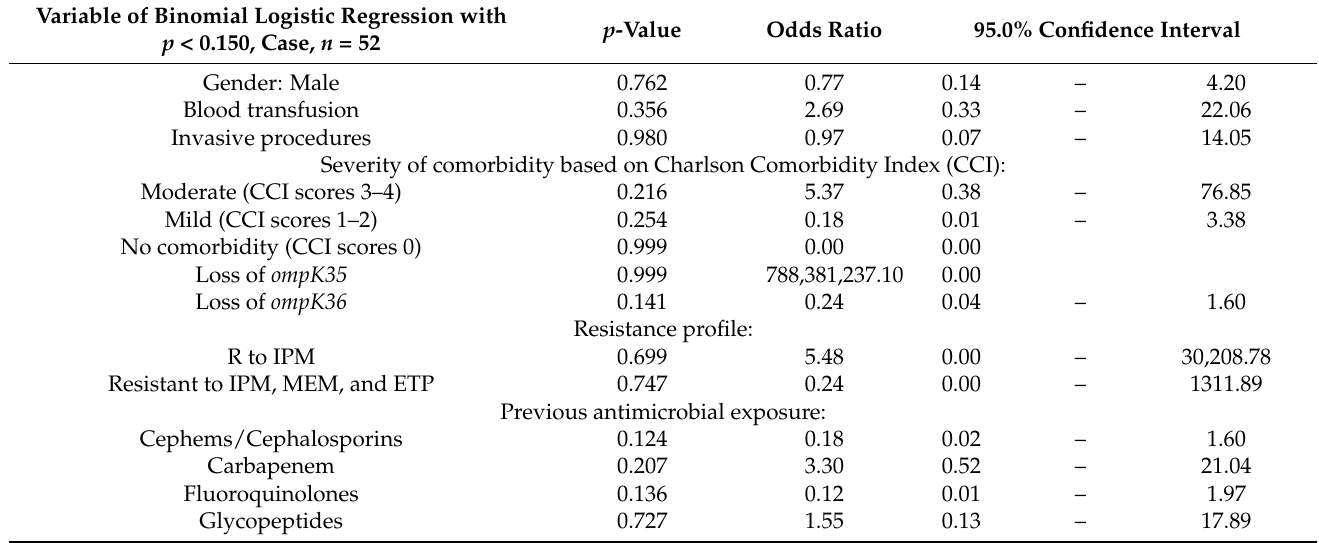
Table 7. Binomial logistic regression model for all-cause in-hospital mortality among all NC-CRKP